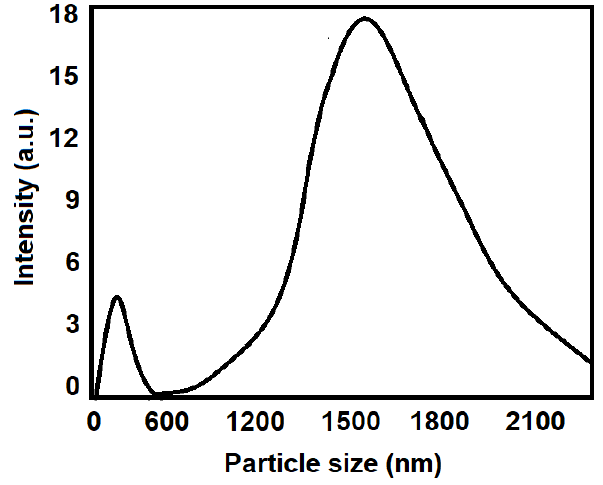
Figure 1. Particle size distribution of CHL-loaded GO nanocomposite in aqueous media .